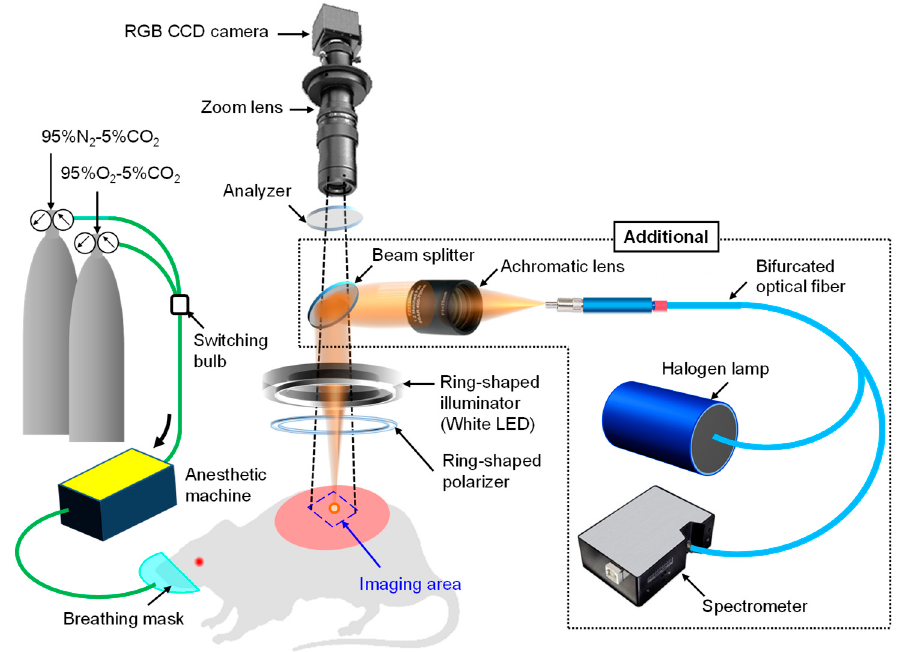
Figure 11. Schematic diagram of experimental configuration for image acquisitions and the spectral reflectance measure- ments.